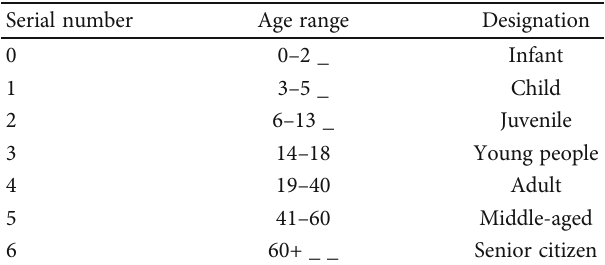
Table 5: Age range